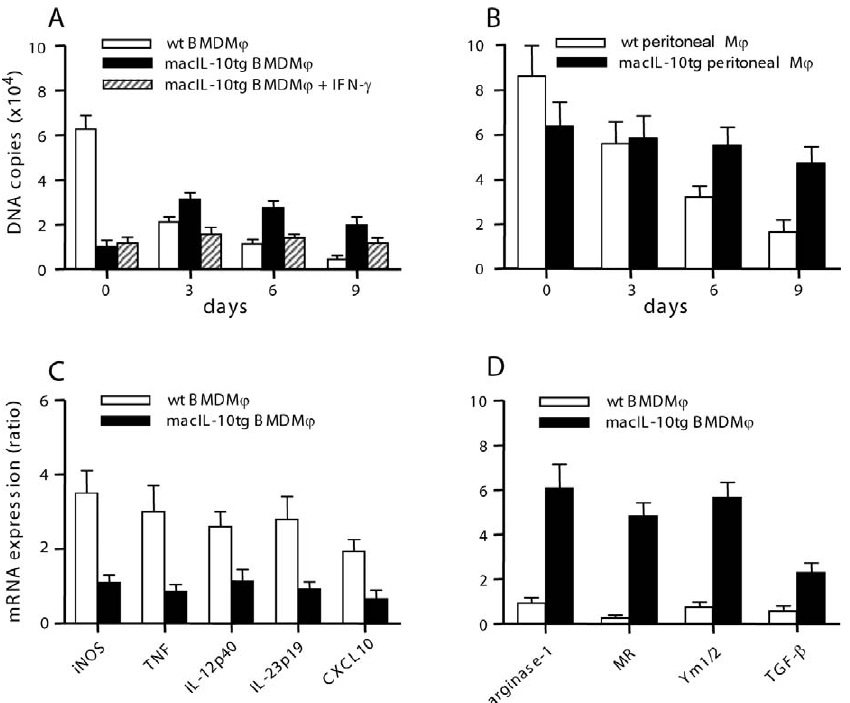
Figure 4. M / Responses to C. burnetii (A and B) BMDM / (A) and peritoneal M / (B) were infected with C. burnetii for 4 h and cultivated for different periods. C. burnetii burden was measured by qPCR. The results are expressed as the mean number 6 SD of C. burnetii DNA copies. (C and D) BMDM / were stimulated by C. burnetii for 6 h, and transcripts for molecules corresponding to M1 phenotype (C) or M2 phenotype (D) were quantified by qRT-PCR. Results are expressed as the ratio of expression levels in C. burnetii -stimulated M / versus unstimulated M / ( n ¼